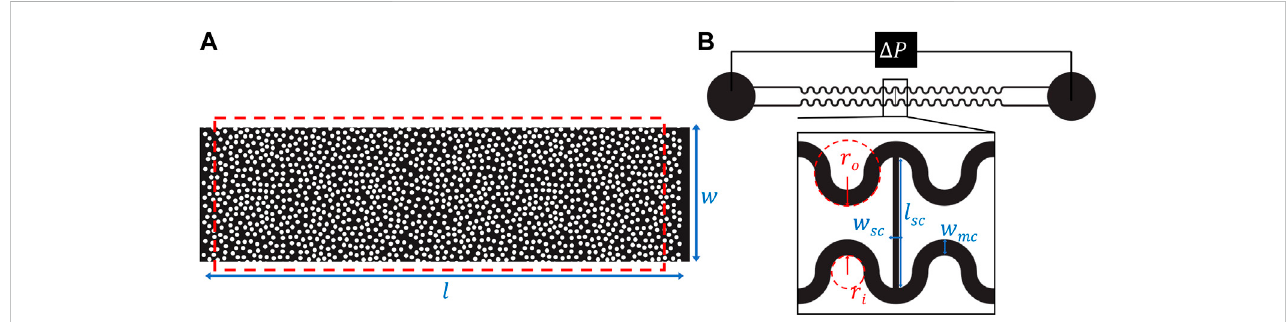
FIGURE 2 Sketches of the employed micro fl uidic geometries: (A) Random arrangement of about 1,400 cylinders with a diameter d ≈ 0.032 mm, and a height h 1 ≈ 0.030 mm. The array has the lateral dimensions of l = 3.5 mm and w = 1 mm, The red box indicates the fi eld of view; (B) Two symmetric serpentine channels with a width w mc = 0.125 mm that are connected by a perpendicular side channel with a width of w sc = 0.050 mm and a length of l sc = 1 mm. The inner and outerradii ofcurvature of theserpentine channels were r i = 0.125mm and r o = 0.250 mm. The height h 2 of themicro fl uidic channels was approximately 0.045